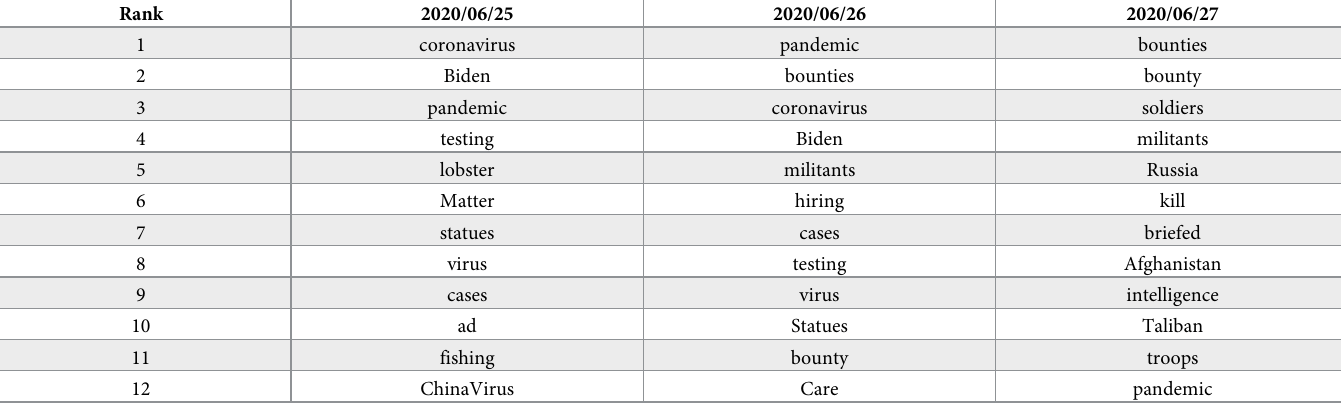
Table 1. Top 12 most narratively dominant 1-grams for Trump-matching tweets for an example three day period. The sharp rise of the Russian bounties for Taliban soldiers to kill US troops, along with the fall of other stories, gives an example of a microscopic detail of story turbulence we aim to quantify macroscopically.